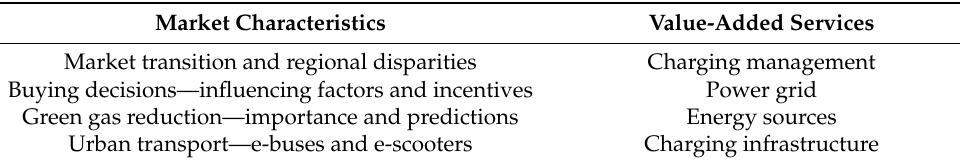
Table 6. Availability of search queries in Web of Science and Scopus databases.